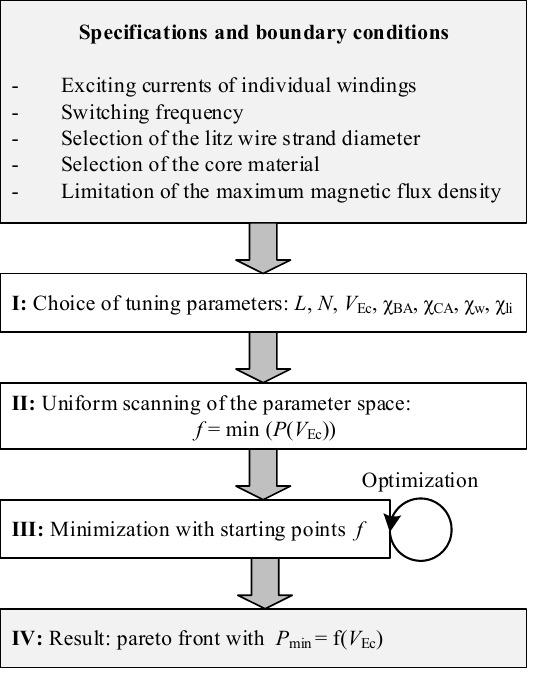
Figure 17. Flowchart for optimal design of inductive components.